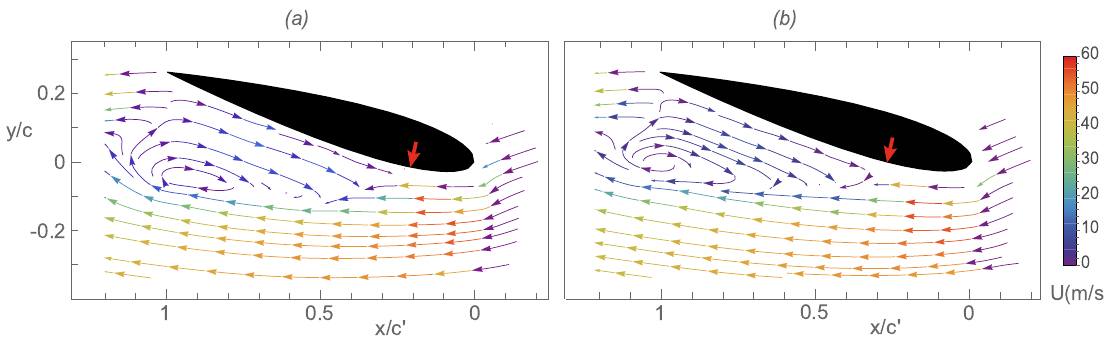
Figure 14. ( a ) Plasma-off and ( b ) plasma-on flow field at T A for α = 14.5 ◦ and U ∞ = 35